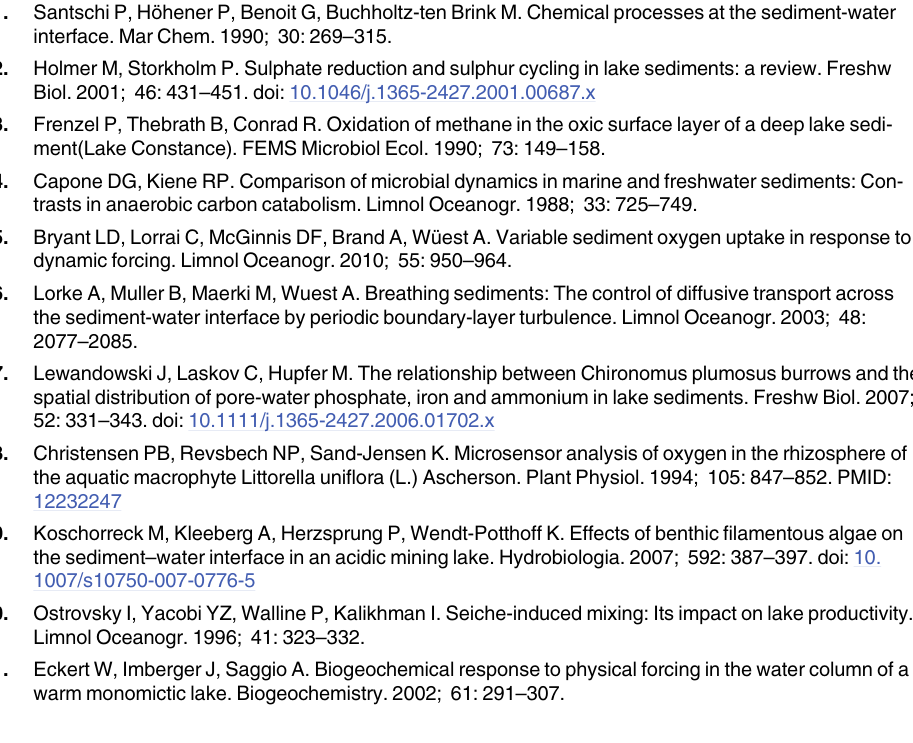
S2 Table. Summary of the statistic results from envfit algorithm within the NMDS plots. The p values are given, all significant values are italicized. All values still significant after Bon- ferroni-Holm correction are written in bold and italic letters. Furthermore, stress values of NMDS plots are